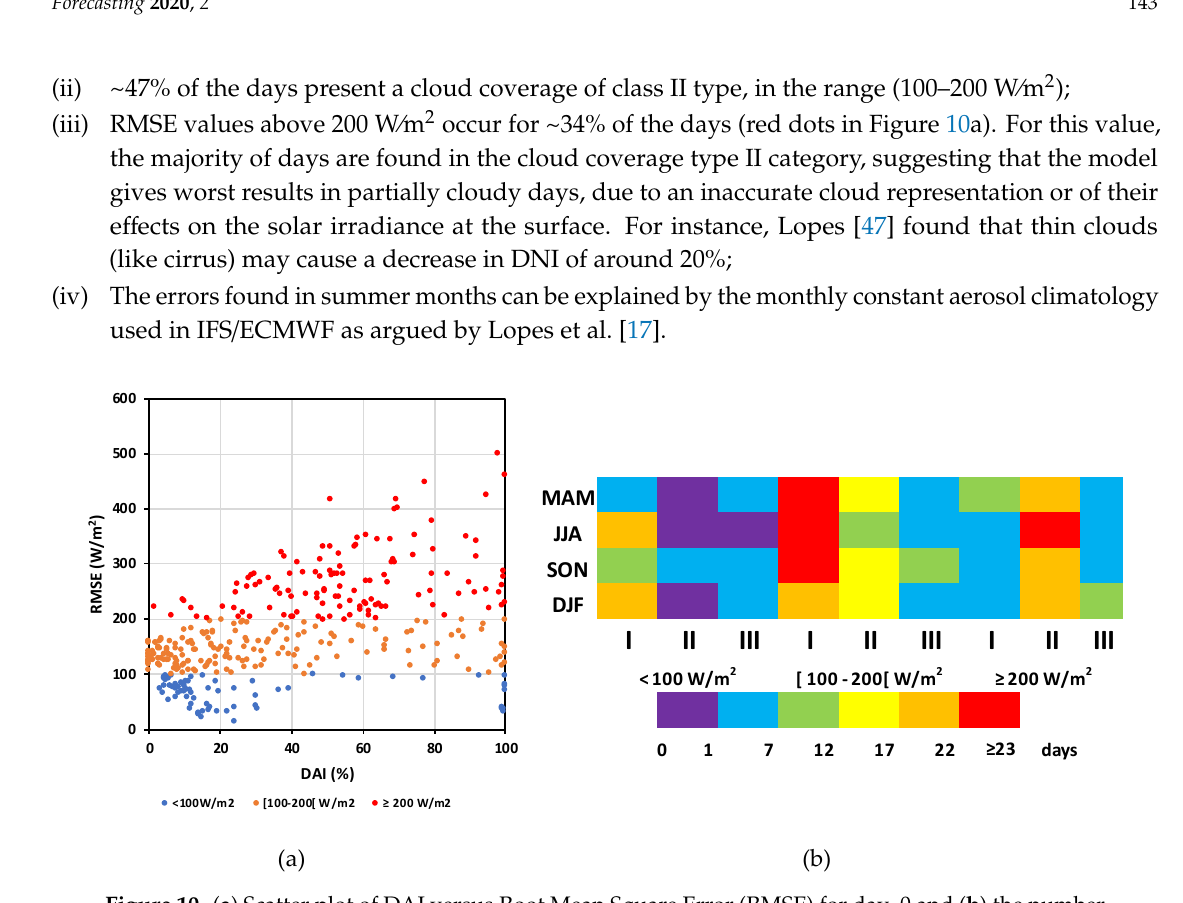
Figure 10. ( a ) Scatter plot of DAI versus Root Mean Square Error (RMSE) for day_0 and ( b ) the number of days in a seasonal basis within di ff erent ranges of forecast errors grouped in classes, according to the cloud coverage–class I (0–2 oktas), class II (3–5 oktas), or class III (6–8 oktas) for